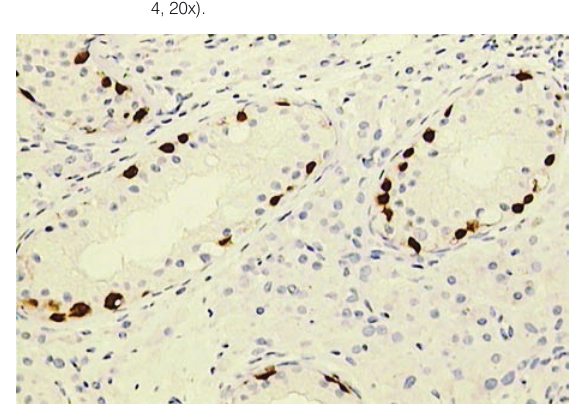
Figure 1. Strong nuclear immunoreactivity of OCT 4 is limited to the neoplastic cells. (immunohistochemistry with OCT 4,